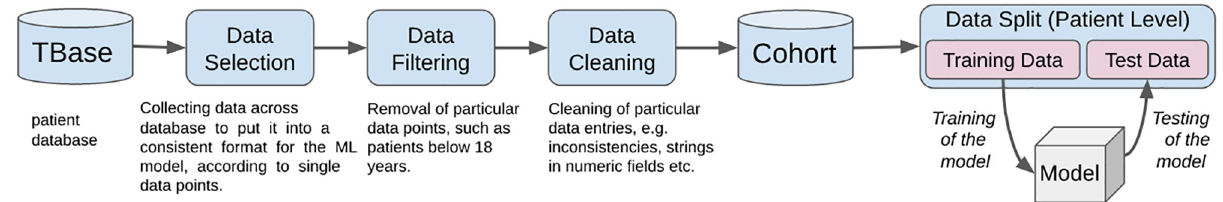
Fig 1. Overview of the data flow from the patient database to the model. The last part about the patient-level data split depends on the evaluation. In the case of internal evaluation, the data split represents the 10-fold cross-validation. In the case of the reader study, the split has been applied just once.